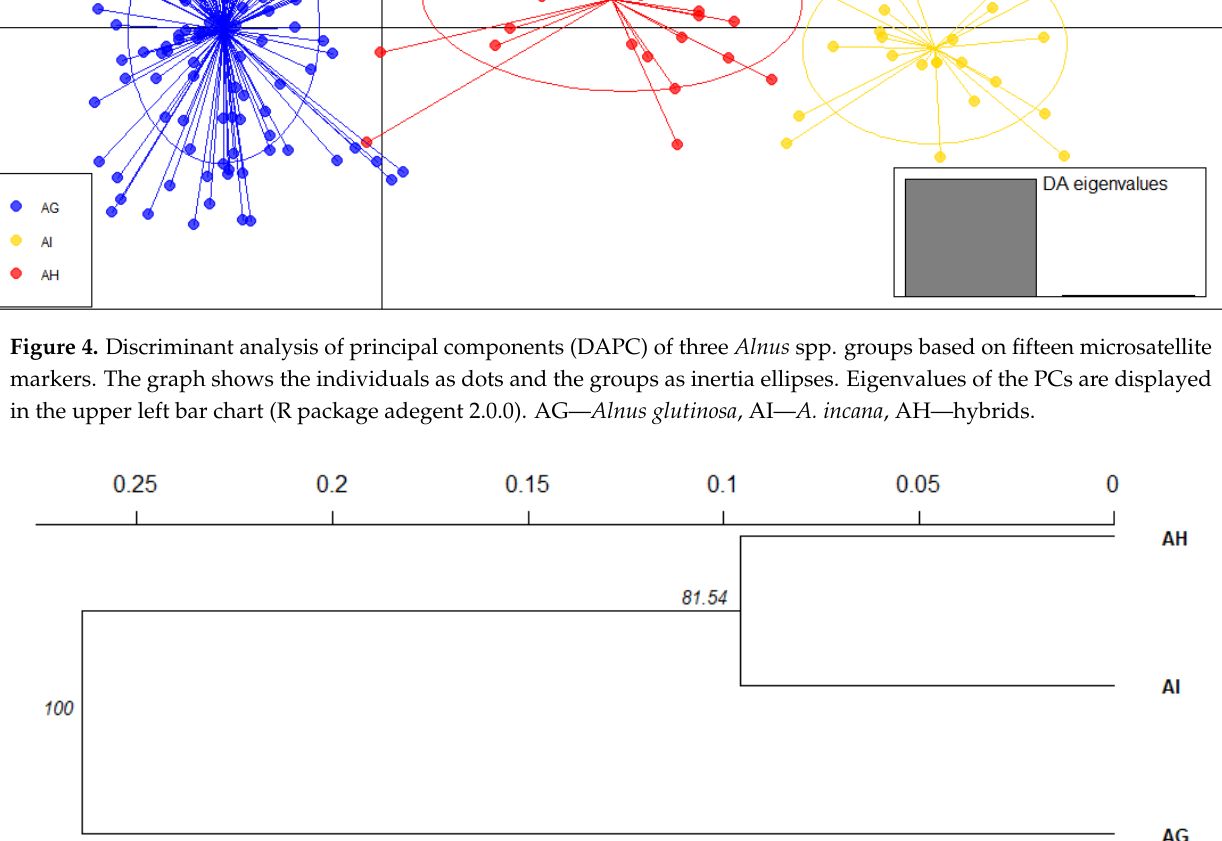
Figure 5. Results of UPGMA clustering based on Nei’s 1978 genetic distances [98]. The significance of branch nodes was